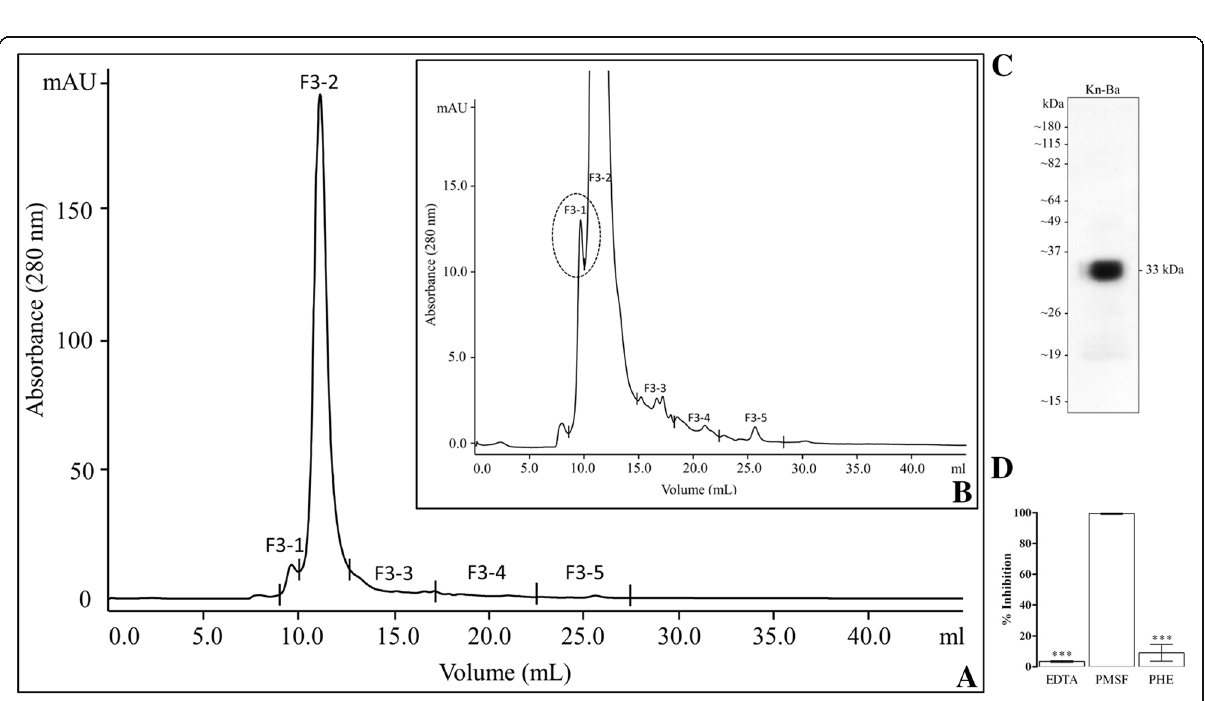
Fig. 2 Purification and identification of Kn-Ba. a The third chromatographic peak (F3) obtained from the first purification step was subjected to another molecular exclusion chromatography on a Superdex 75 10/300 GL column, equilibrated and eluted with ammonium acetate 50 mM in a climate-controlled room (22 ± 2 °C). Samples were collected at a flow rate of 0.4 mL/min, and their protein content was monitored by recording the absorbance at 280 nm. b Zoom and highlight of F3 – 1, substrate-cleaving activity containing peak. c Silver-stained SDS-PAGE (10%) of the 33 kDa protein band corresponding to F3 – 1, which was denominated Kn-Ba. d The proteolytic activity of Kn-Ba, pretreated or not with EDTA, PMSF and PHE upon Abz-FRSSR-EDDnp FRET substrate. This assay was performed in quadruplicate. Results were expressed as inhibition percentage of proteolytic activity ± SEM and analyzed statistically using One-Way ANOVA test followed by Tukey HSD post-hoc tests (* p <